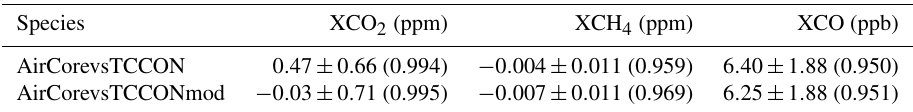
Table 5. Statistics of the intercomparison results for AirCore vs. TCCON and non-linearity-corrected TCCON data sets for measurements performed in 2017 with SZA < 75 ◦ for the TCCON measurements. The values provided are the mean bias ± the standard deviation and the correlation coefficient ( r